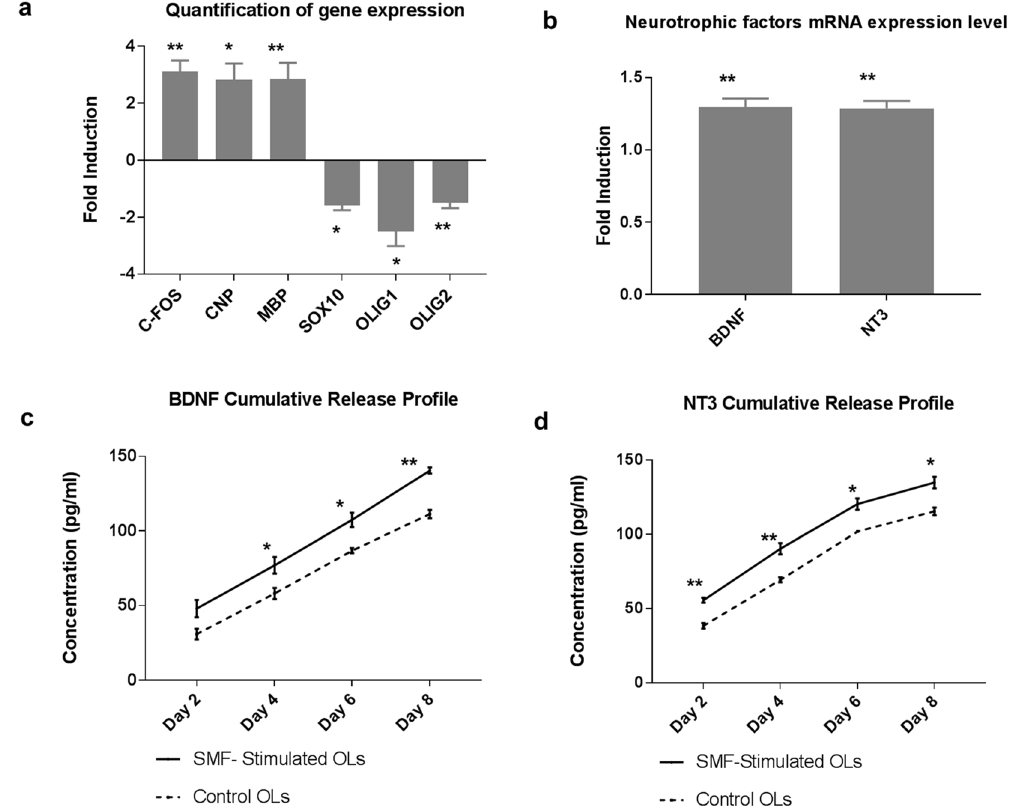
Figure 3. Effects of SMF on oligodendrocyte differentiation and neurotrophic factor release. ( a ) Quantification of gene fold changes in SMF stimulated oligodendrocytes as compared to control (non-stimulated), ( b ) mRNA expression levels of neurotrophins BDNF and NT3 in SMF stimulated oligodendrocytes as compared to control, ( c , d ) Cumulative release profile of BDNF and NT3 ( * p < 0.05, ** p < 0.01) in SMF stimulated and non- stimulated